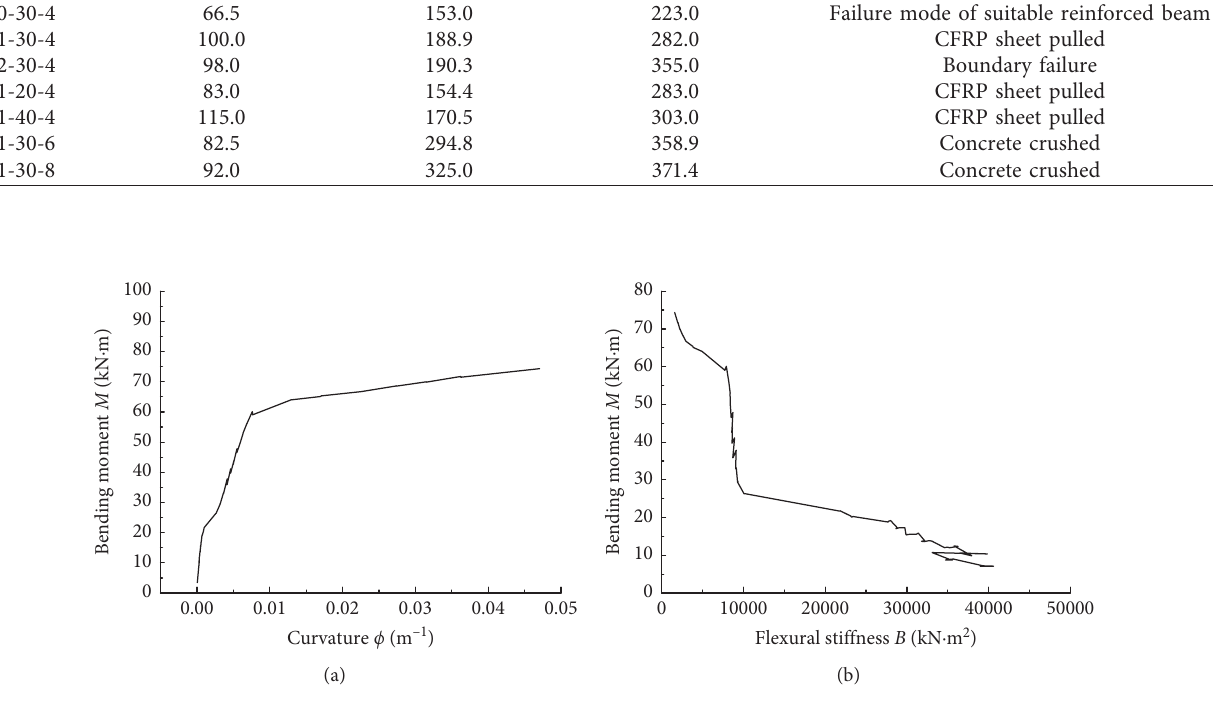
Figure 4: B-0-30-4. (a) Bending moment-curvature curve. (b) Bending moment-stiffness